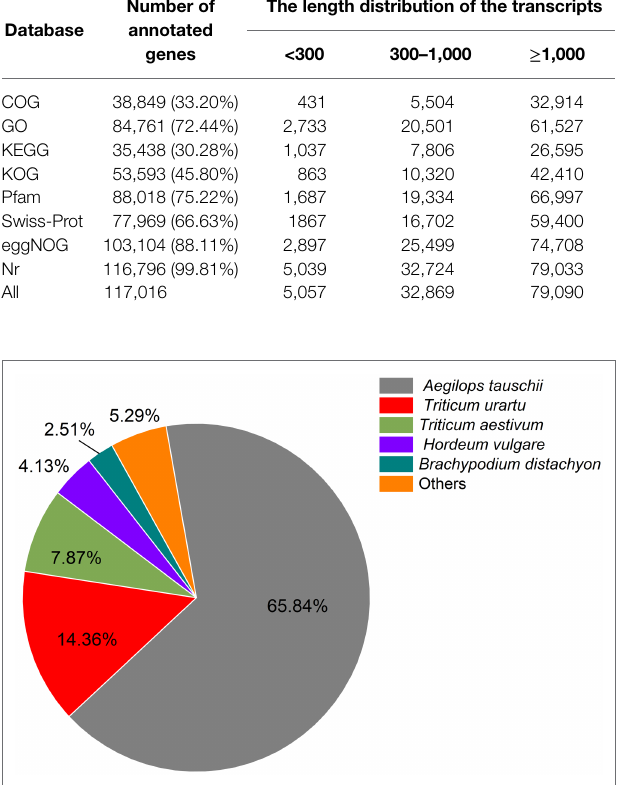
TABLE 2 | Summary of the gene functional annotation and the length distribution of the transcripts. Number of Database annotated